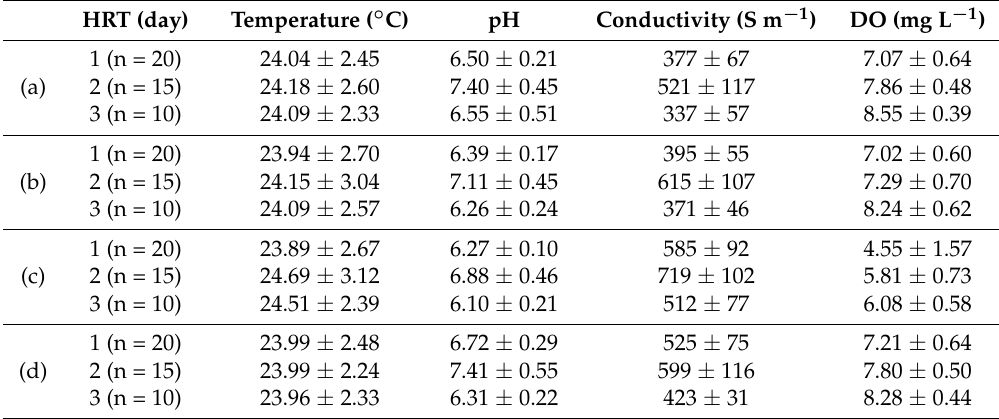
Table 2. The physicochemical parameters in the effluent of bioretention mesocosms. HRT (day) Temperature ( ◦ C) pH Conductivity (S m − 1